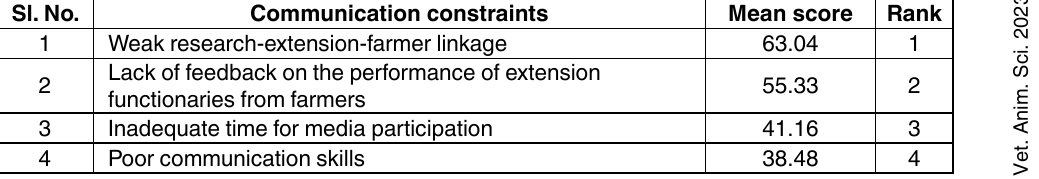
table 5. Communication constraints as perceived by the FEFs of DDD, Kerala sl.